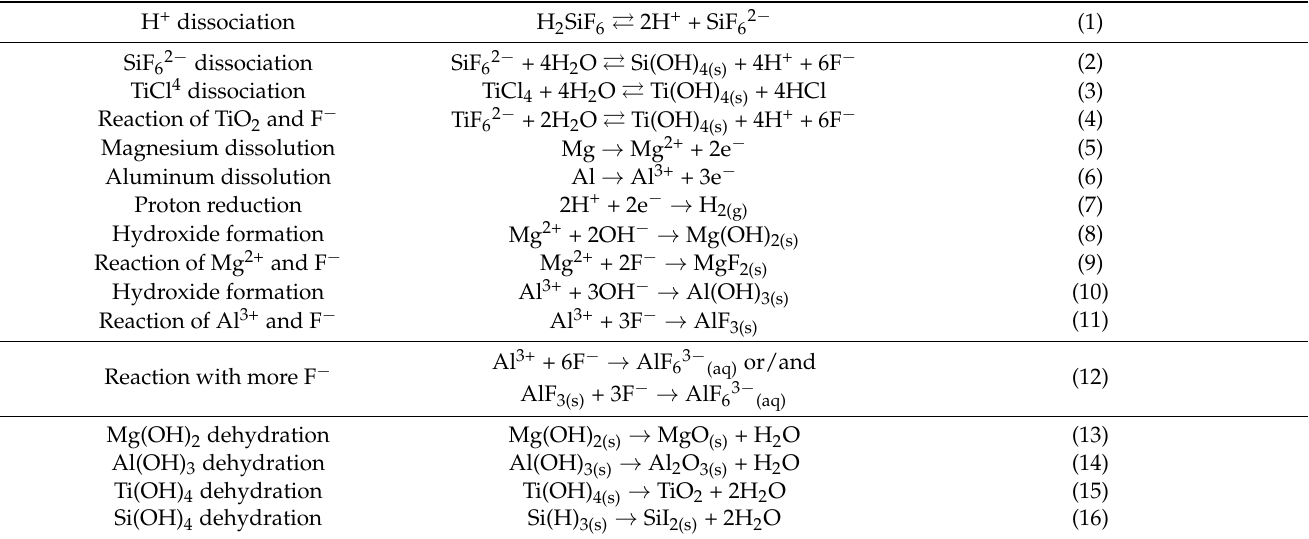
Table 2. The overall electrochemical and chemical reactions in the titanate conversion bath and at the surface of the AZ31 substrate. Reprinted from [125] with permission from IOP. The conversion bath was composed of 0.01 M TiCl 4 , 0.01 M H 2 SiF 6 , and 5 mL/L HNO 3 at 40 ◦ C at pH